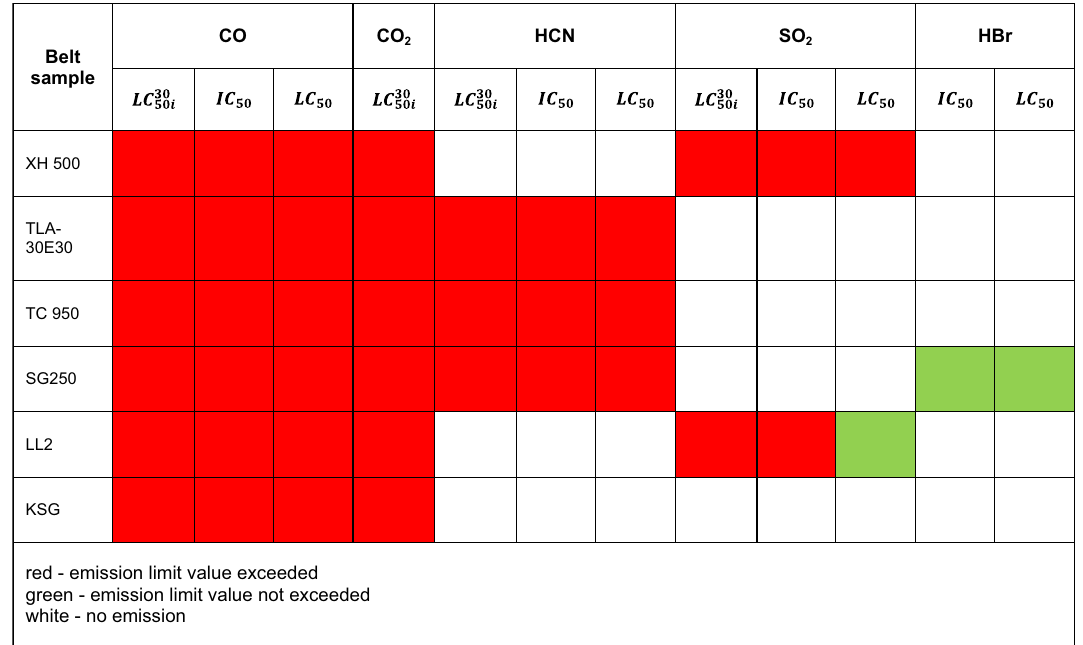
Table 4. Characteristics of the emission of toxic compounds during thermal decomposition and combustion of the tested belts under the analysed